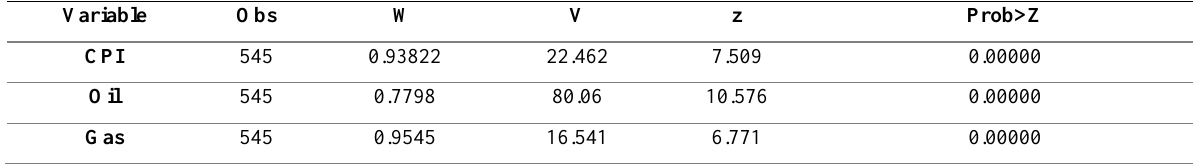
Table 2: Shapiro-Wilk normality test